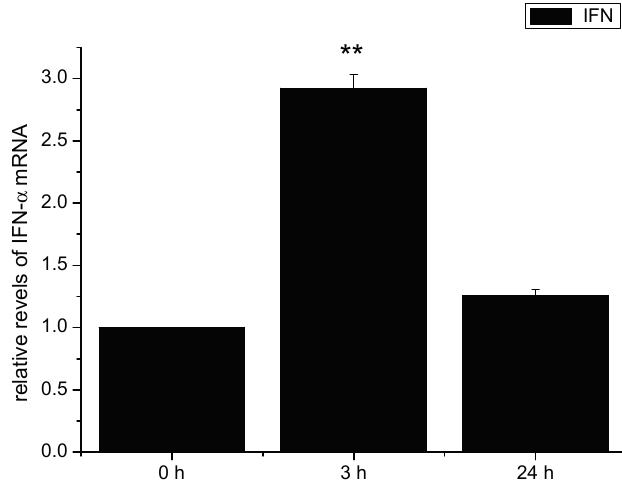
Figure 6. Expression of the INF- α in ZF4 transfected with total RNA from ZF4 cultures either 3 or 24 h after SHVV infection. Data were shown as mean ± SE ( n = 3). The data were submitted to one-way analysis of variance (one-way ANOVA) followed by Fisher’s LSD test using SPSS. The asterisk indicated a statistically significant difference ( ** p <